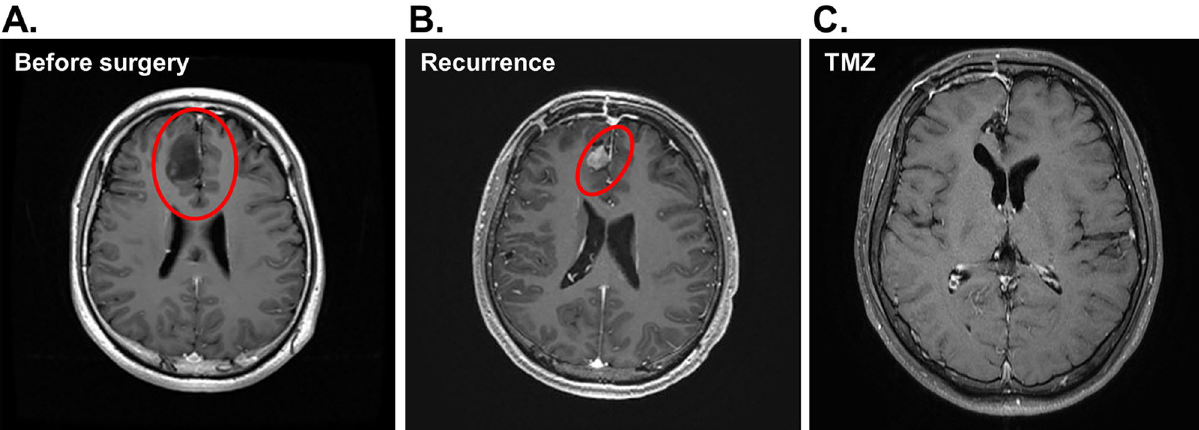
Figure 6. Radiological response of the brain lesion of patient #3 to temozolomide. ( A ) Axial MRI before surgery with the tumor area circled. ( B ) The follow-up MRI imaging after surgery. ( C ) Follow-up axial imaging after treatment by Temozolomide (TMZ). The patient showed complete